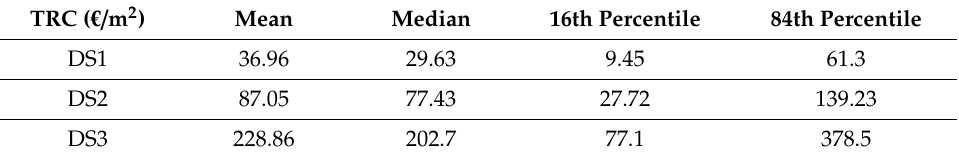
Table 4. Median, 16th and 84th percentiles for TRC depending on the maximum DS. Figure 12. TRC due to infills depending on the maximum attained DS.